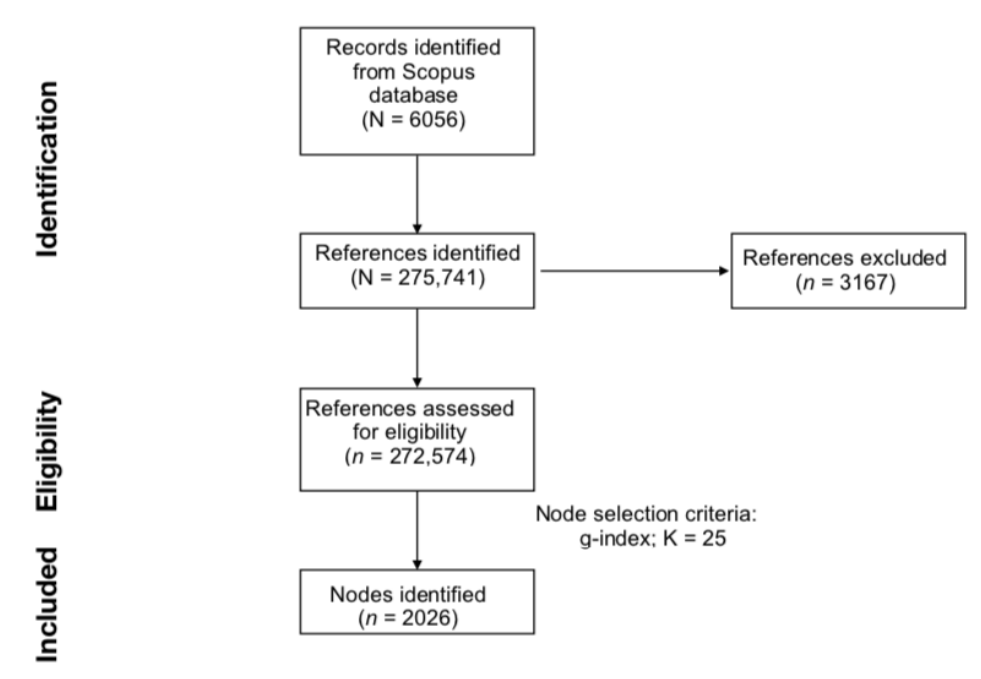
Figure 1. PRISMA flowchart for search criteria and reference